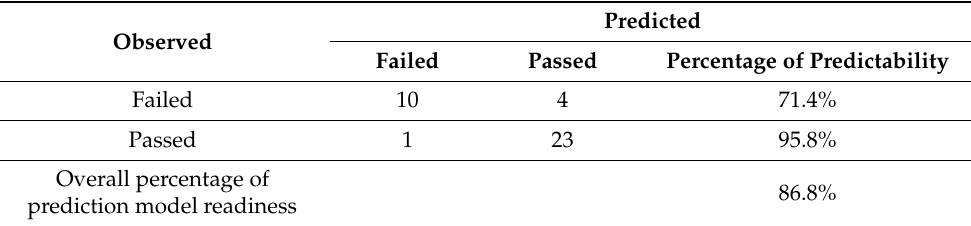
Table 3. Logistic regression model for predicting the dependent variable and final grade in the rehabilitation course.